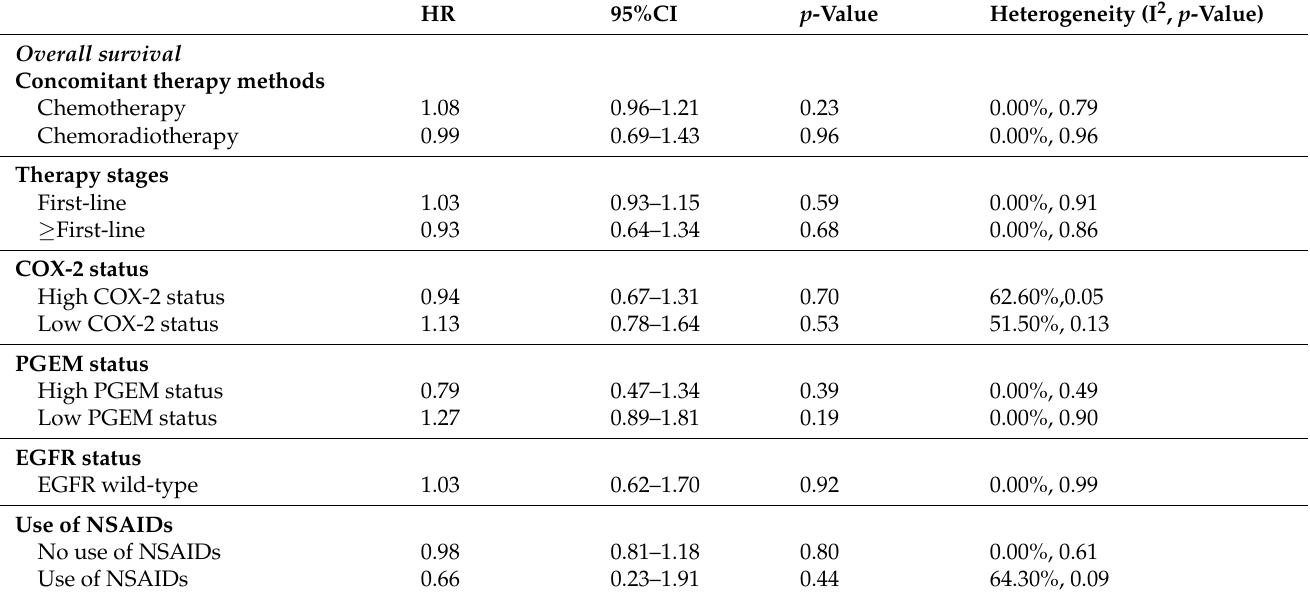
Figure 2. Efficacy of celecoxib-combined palliative therapy in different cancer types on over- all survival (OS) ( A ) and progression-free survival (PFS) ( B ). HR: hazard ratio; CI: confidence interval [29,31,41,42,48,50–52,56,58–63]. Table 2. The results of subgroup analyses on the survival efficacy of celecoxib combined with palliative therapy. HR 95%CI p -Value Heterogeneity (I 2 , p